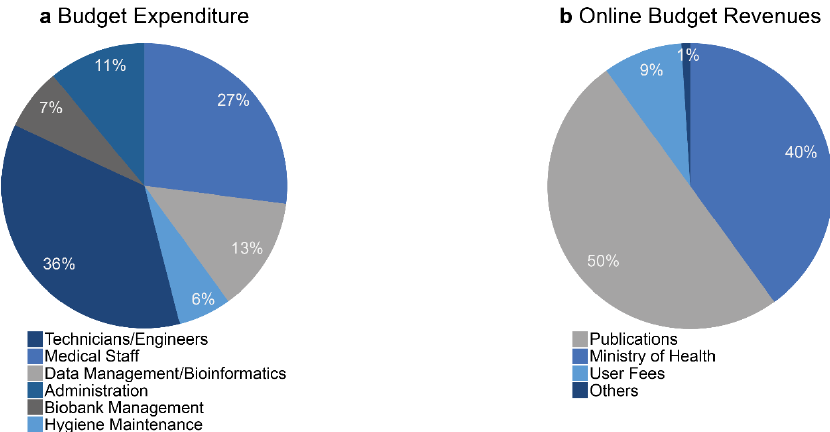
Figure 5. Economic model of the biobank BB-0033-00025. ( a ) Main sources of spending. ( b ) Main sources of income.